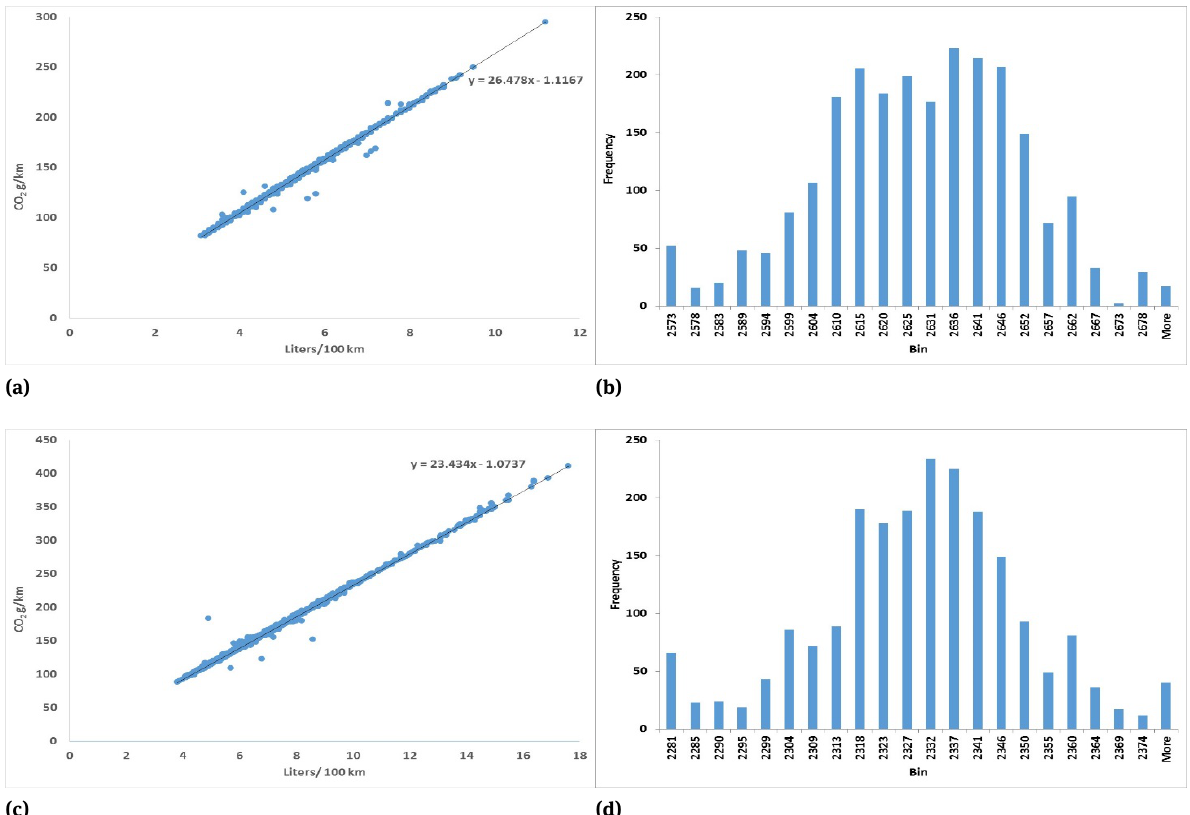
Fig. 1: Fuel economy and carbon dioxide emission data of diesel (a, b) and petrol (c, d) passenger cars.